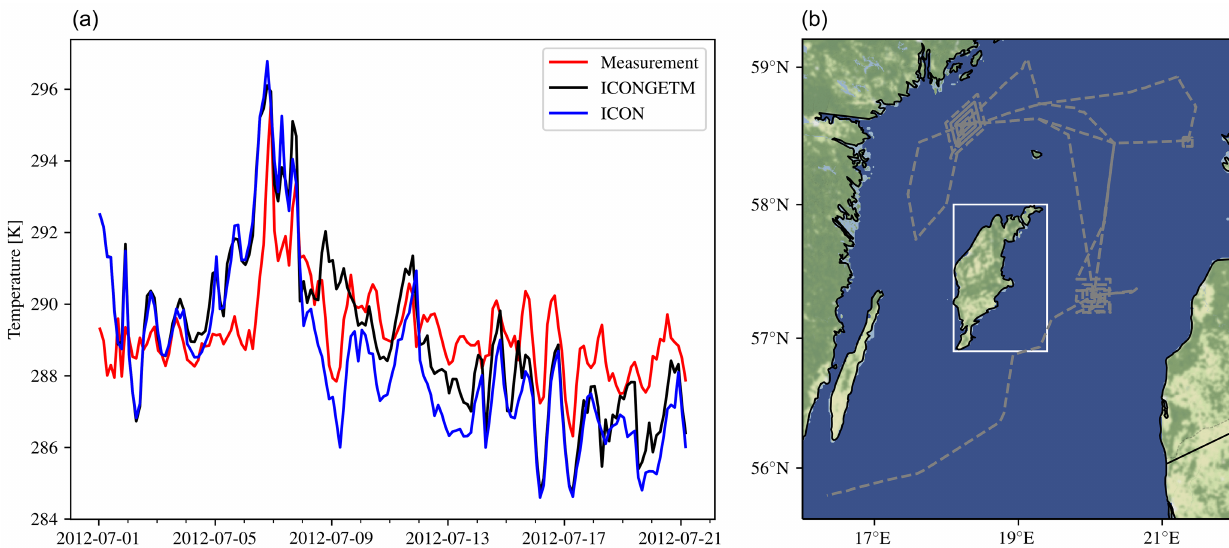
Figure 9. Air temperature at 29.1m height in the central Baltic Sea over the period 1–21 July 2012 (a) . Compared are model results from the two-way coupled ICONGETM and uncoupled/one-way coupled ICON simulations with measurements onboard the RV Meteor ; ship track shown in (b) . The white frame shows the island of Gotland, similar to Fig. 2.